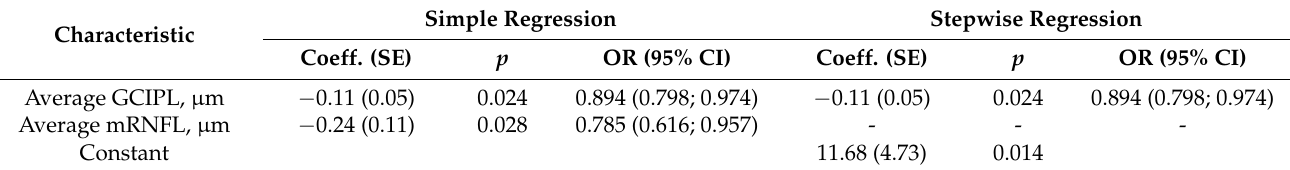
Table 3. Logistic regression model for MS and NSWMLs patients.